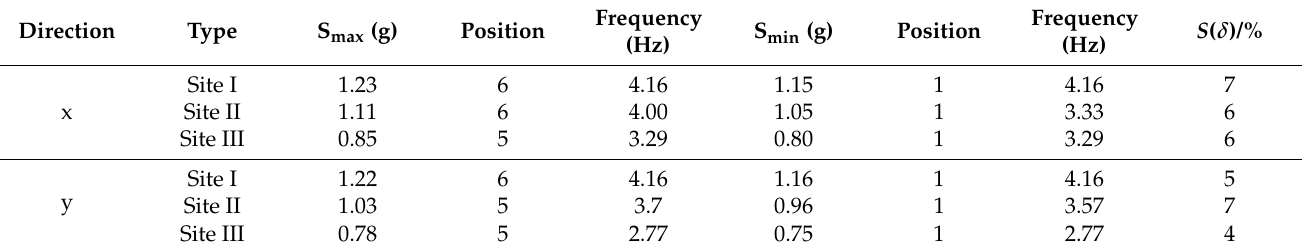
Table 4. Acceleration floor response spectrum at different positions of the raft foundation (2–10